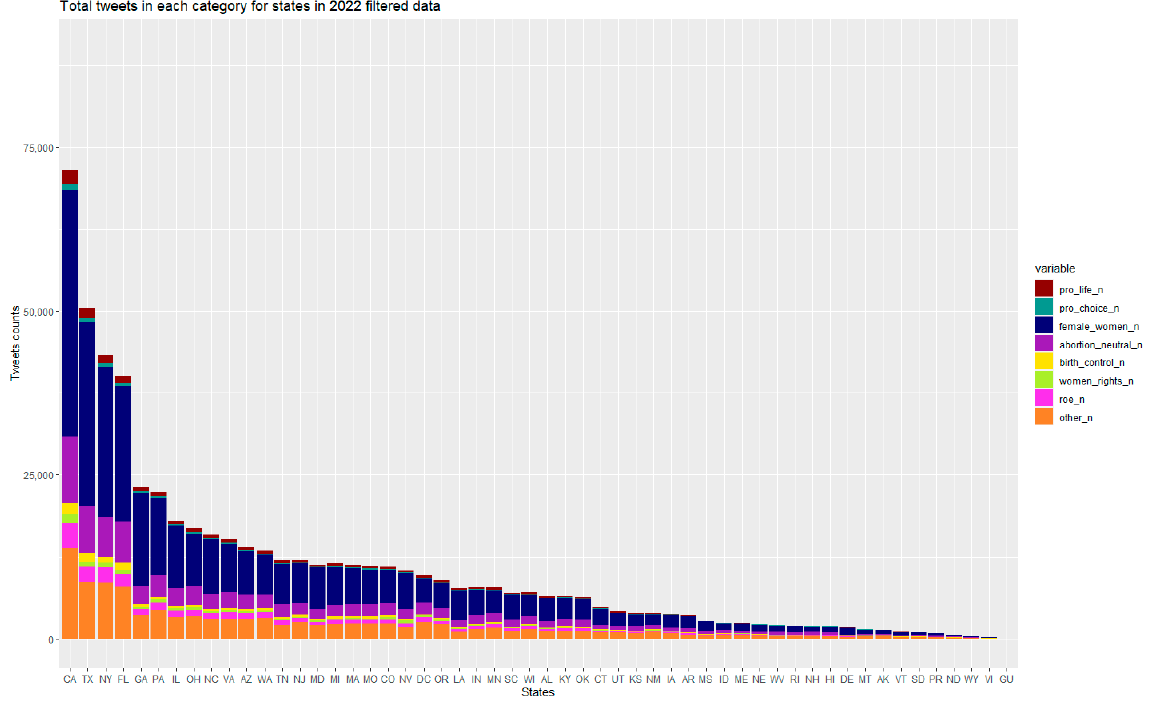
Figure 3. Total number of tweets in each topic category from the event-related tweets, by state (1 May–15 July